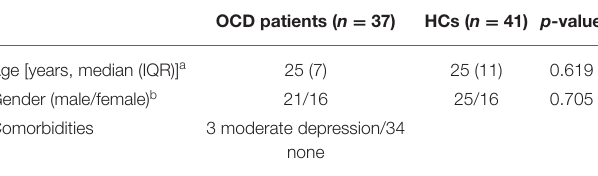
TABLE 1 | Clinical and demographic characteristics of the